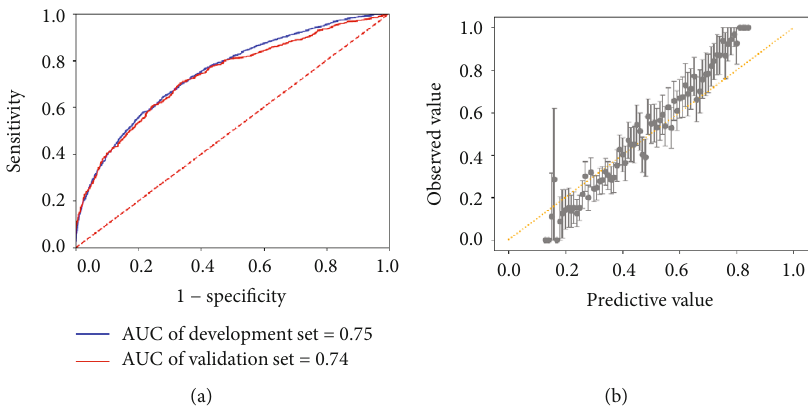
Figure 4: Predictive performance of the GBDT model. (a) AUCs of the development and validation cohorts. (b) The graph presents the calibration curve of the GBDT model by showing the relationships between observed and predicted GDM using the GBDT model. Data are presented as mean and 95% CIs.